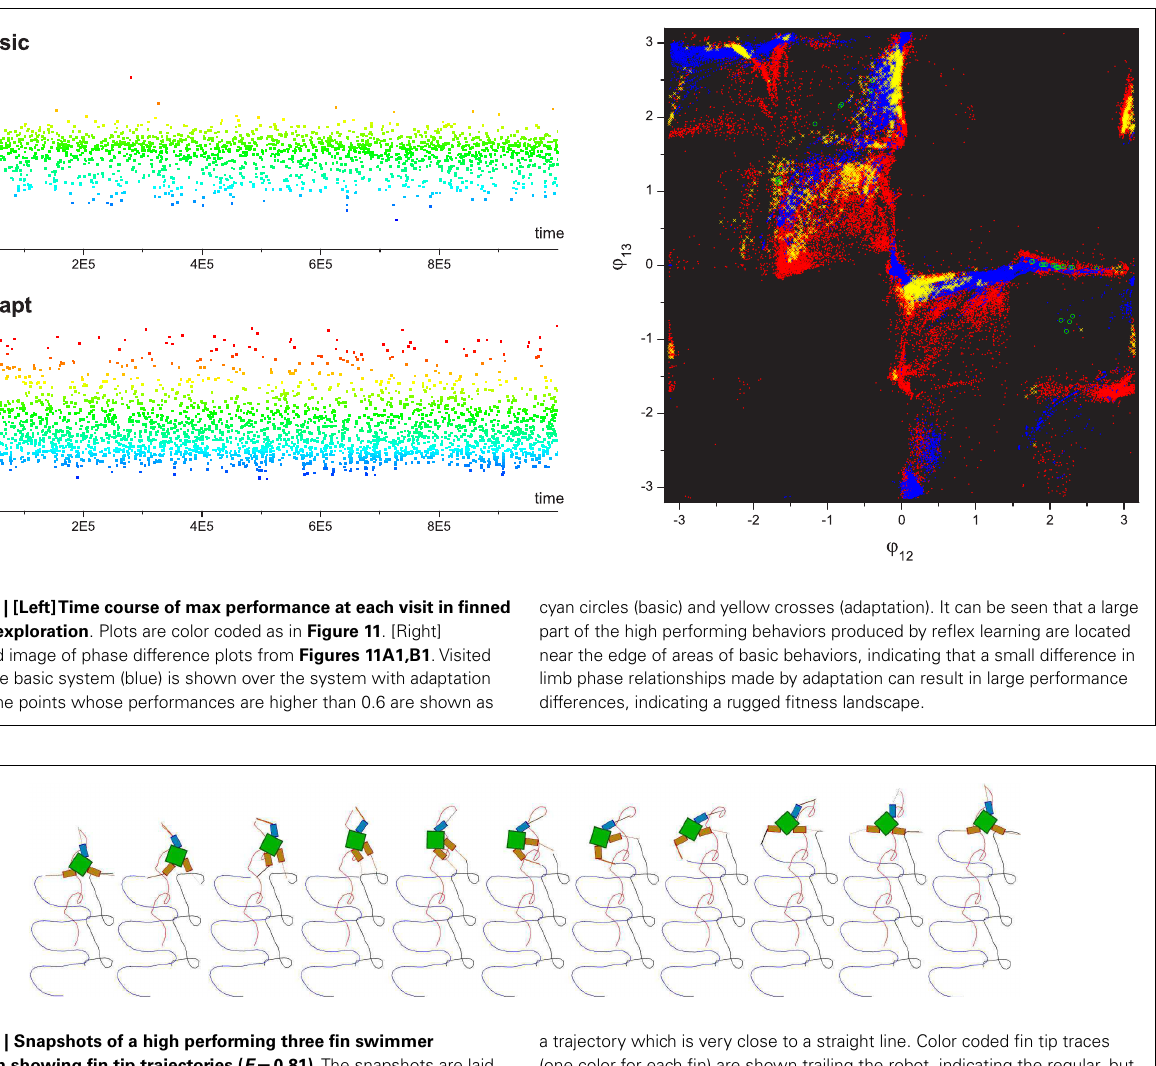
FIGURE 13 | Snapshots of a high performing three fin swimmer locomotion showing fin tip trajectories ( E = 0.81) .The snapshots are laid out left to right showing a sequence where the robot is swimming upwards in